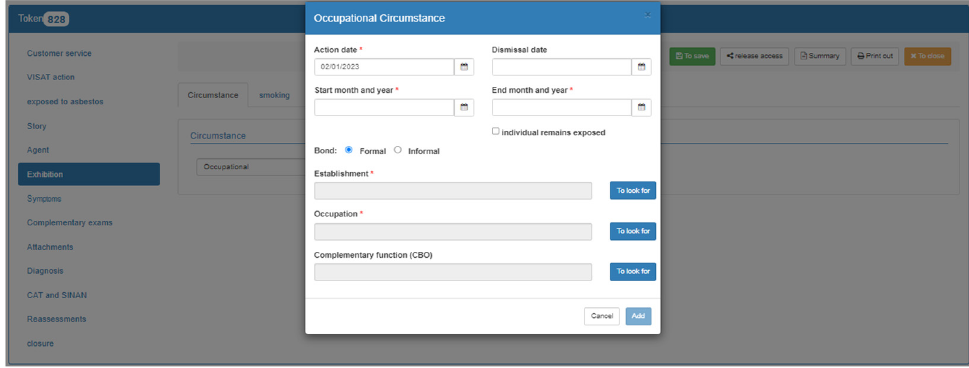
Figure 3. Example of worker’s information registered in the Datamianto system, 2022. Source: Datamianto system, Brazil, 2022.